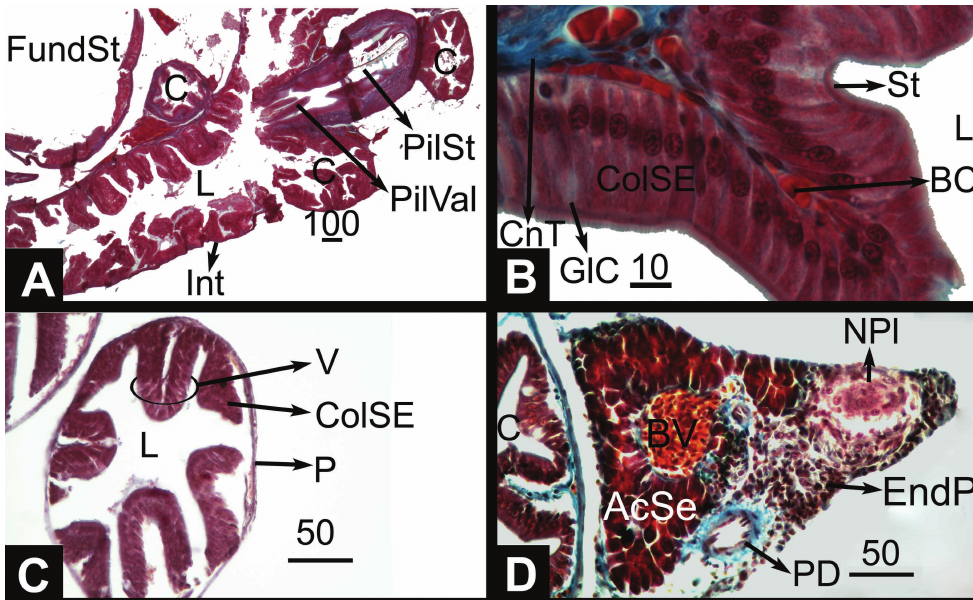
Fig. 6. Histological sections of the alimentary tract of selected species of the Characidae family: A - Transition stomach- intestine of G. ternetzi in transversal section; B - Detail of an intestinal folding in A. anisitsi ; C - Transversal section of a intestinal caeca of Cheirodon interruptus ; D - A. anisitsi pancreas. Abbreviations= AcSe : Serous Acinus BC : Blood Capillary; C : Ceca; ColSE : Columnar Simple Epithelium; CnT : Connective Tissue; EndP : Endocrine Pancreas; FundSt : Fundic Stomach, GlC : Globlet Cell; Int : Intestine; L : Lumen; NPl : Nervous Plexus; P : Peritoneum; PD : Pancreatic duct; PilSt : Pyloric Stomach; PilVal : Pyloric Valve; St : Apical Striations; V : Folding. Bars